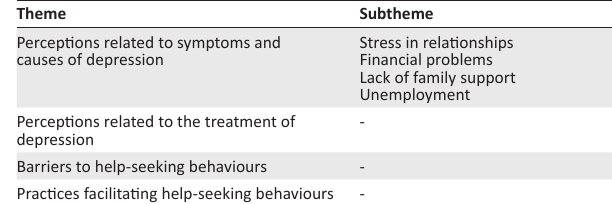
TABLE 2: Emerging themes and subthemes.